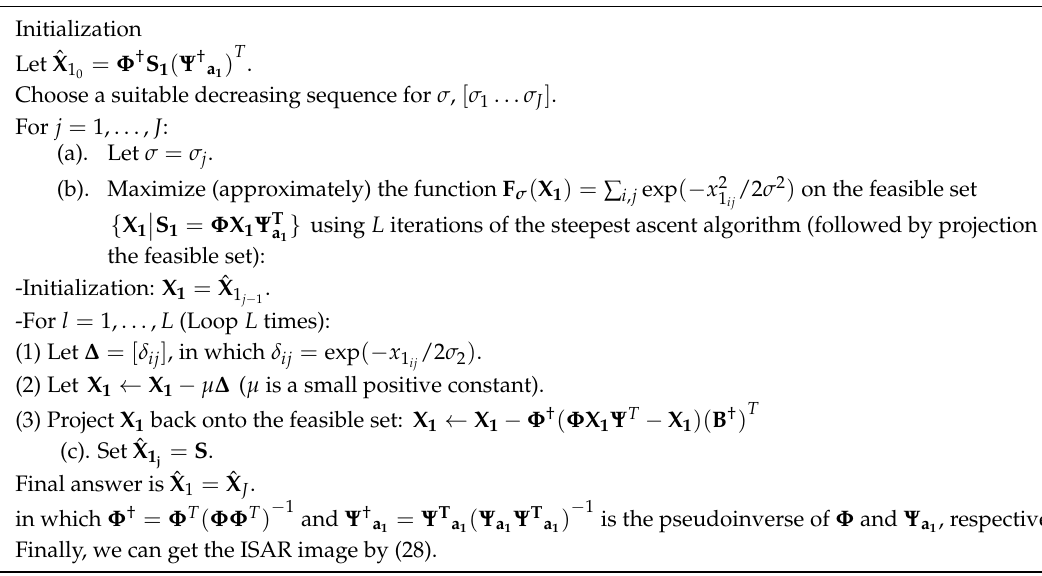
Algorithm 1. Two-dimensional SL0 (2D-SL0)